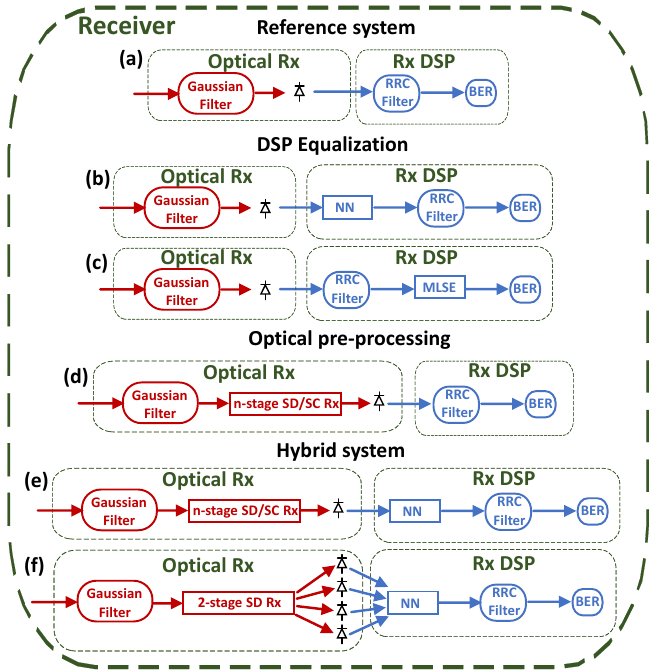
Figure 2. Receiver